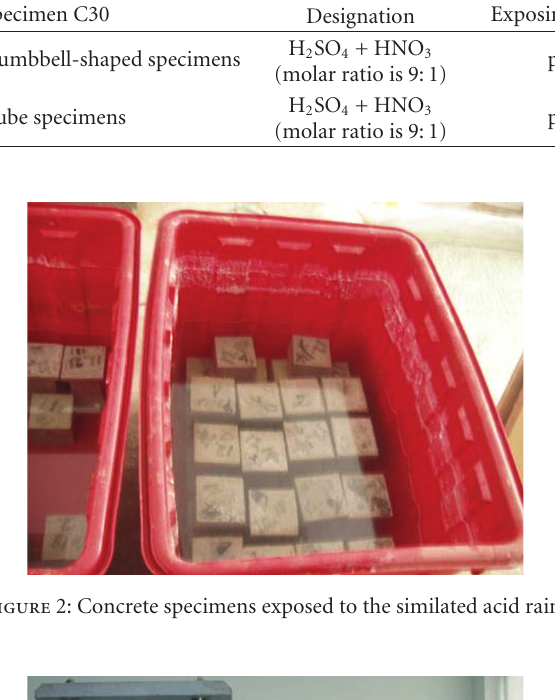
Figure 4: Arrangements of strain gages of on the tensile specimen.